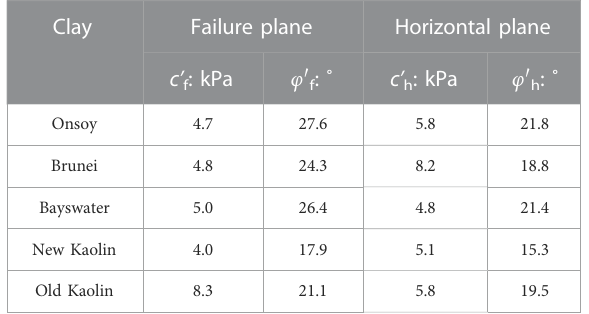
TABLE 4 Summary of strength parameters based on effective stresses.